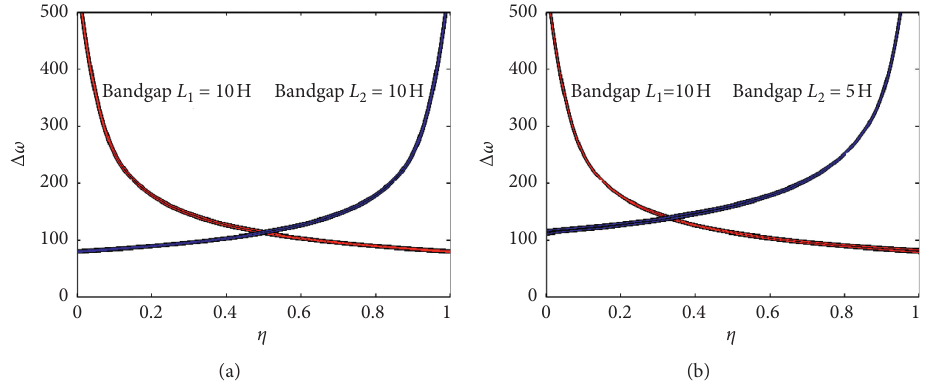
Figure 8: Bandwidth of the two subunits in pure inductance circuit with various length ratios with (a) L L 2 �